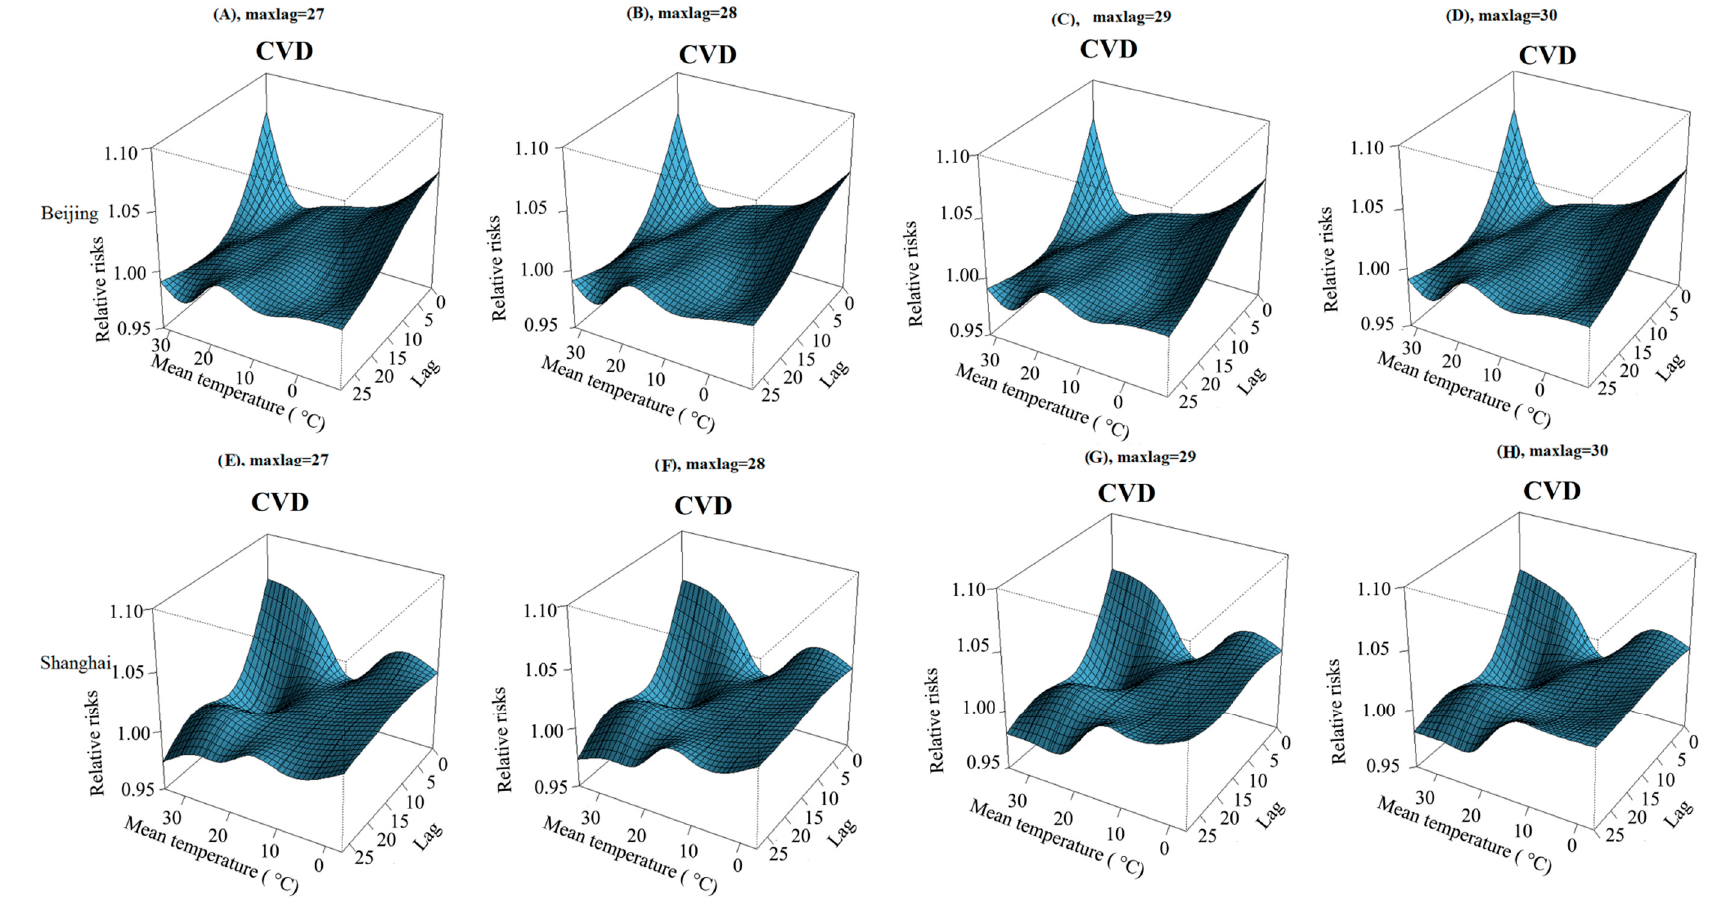
Figure A2. Three-dimensional graph of the relative risks for mortality from cardiovascular disease by temperature (°C) and lag days during 2007 and 2009 in Beijing and Shanghai, China. ( A – D ) A maximum lag of 27–30 days for mean temperature in Beijing, respectively; ( E – H ) A maximum lag of 27–30 days for mean temperature in Shanghai, respectively.